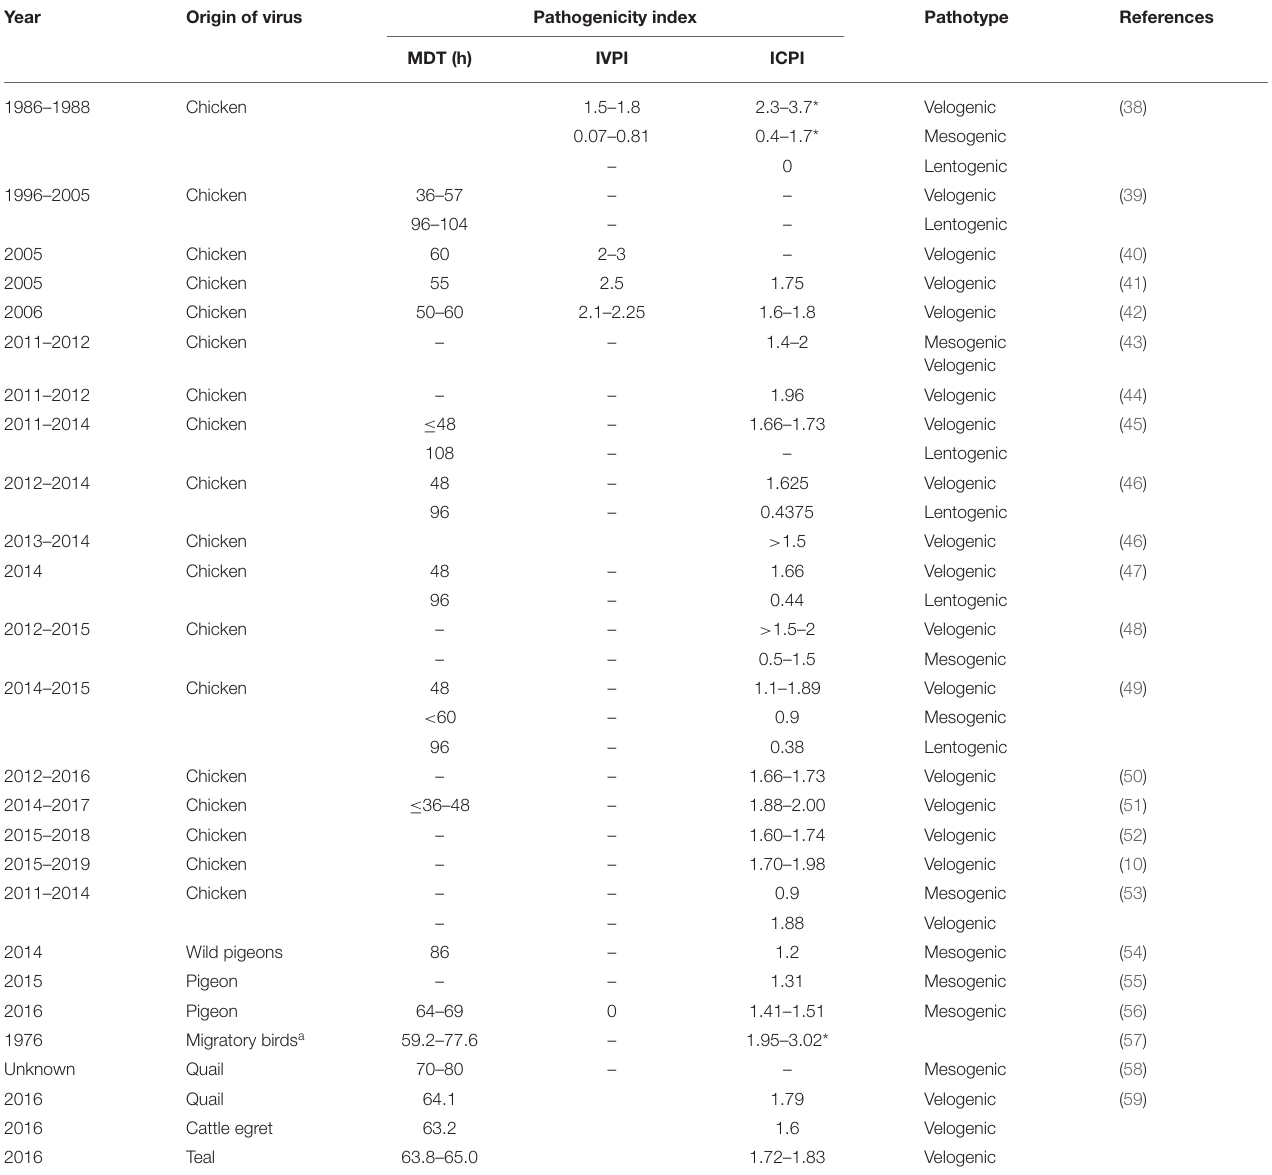
TABLE 1 | Pathogenicity indices of NDV strains isolated from